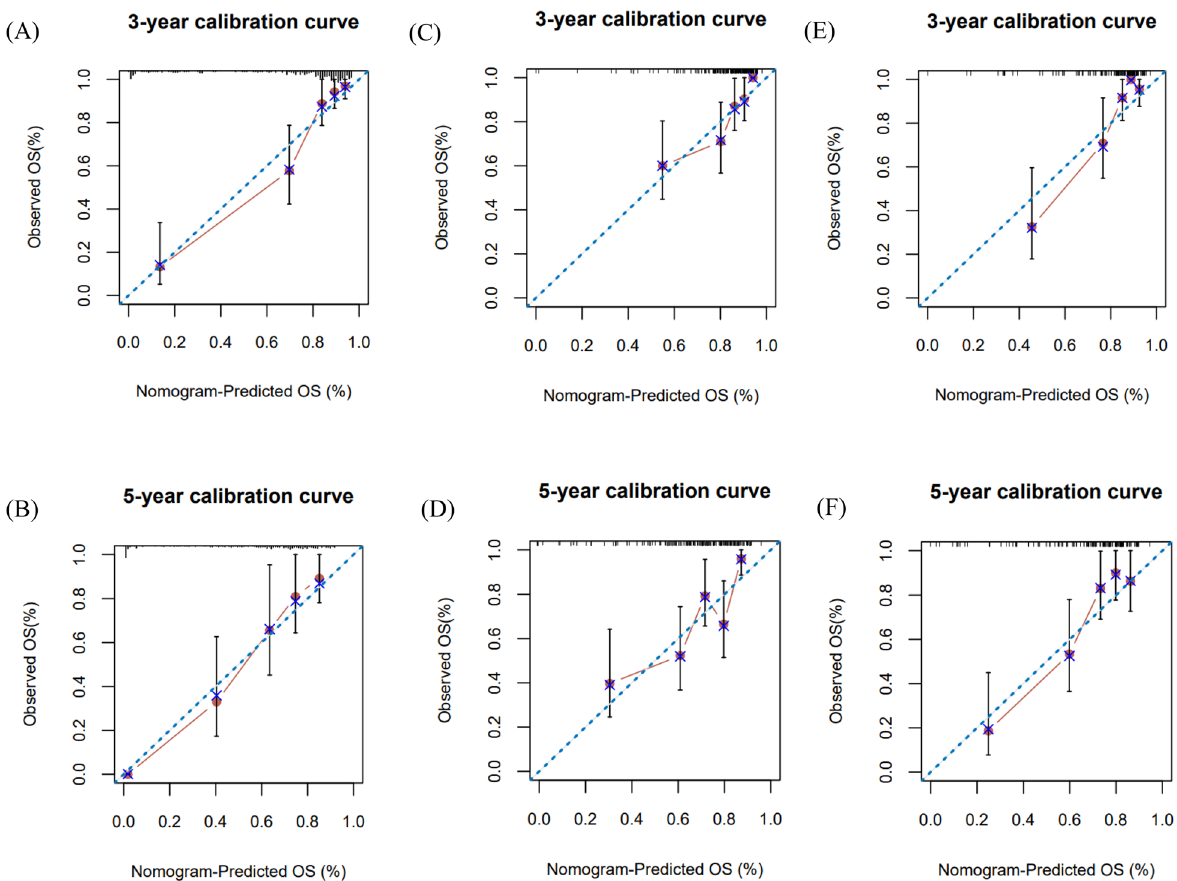
Figure 7. The calibration plot for validation of the nomogram. ( A , B ) TCGA-LGGs dataset ( C , D ) CGGA693 dataset ( E , F ) CGGA325